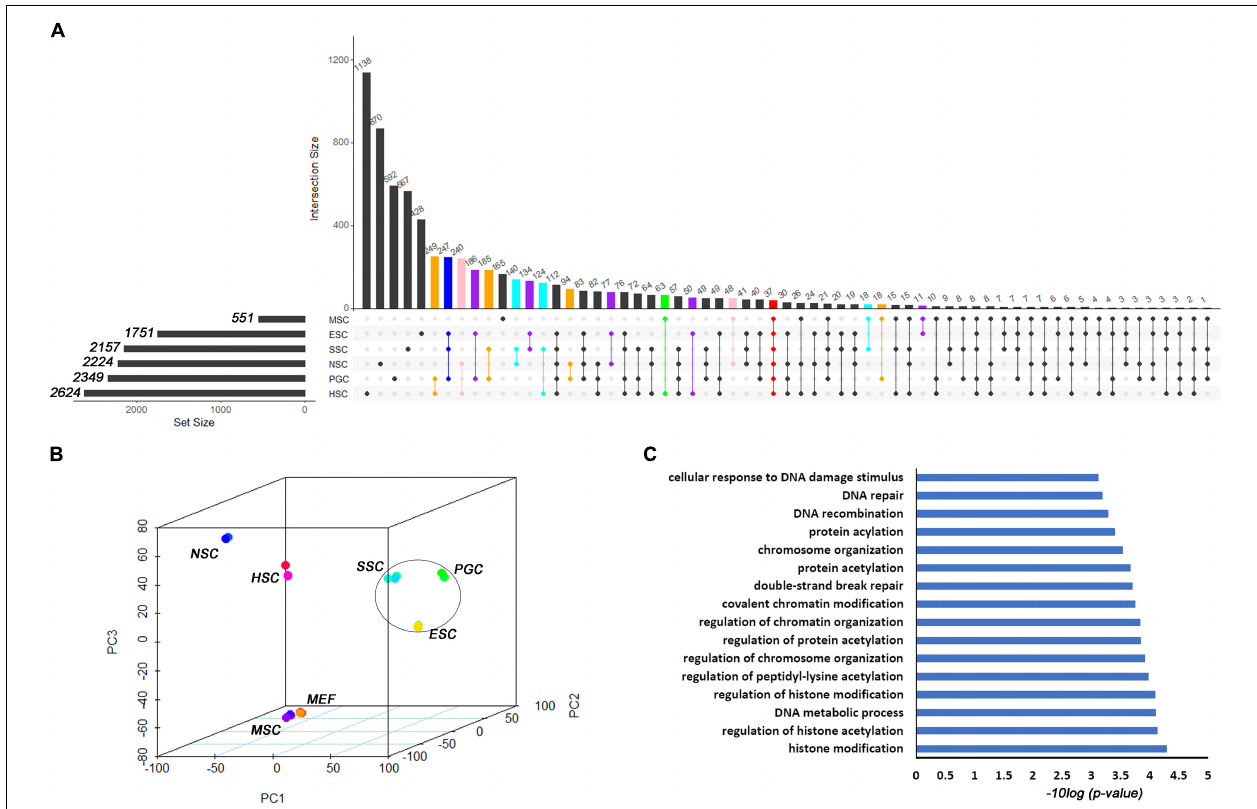
FIGURE 1 | Transcription profiles for ESCs, PGCs, SSCs, NSCs, MSCs, and HSCs. (A) The intersection of highly expressed genes from the six types of stem cells. Dots represents the intersections of the six types of stem cells in the Venn analysis. The bar represents the size of the individual intersections. Dots with lines show highly expressed genes shared by the lined stem cells types. Different intersections of those six types of stem cells are highlighted with different colors. The 37 commonly highly expressed genes among the six types of stem cells are highlighted with red bar. (B) PCA revealed differences among the six types of stem cells. (C) GO analysis of the biological function of the core 37 core commonly highly expressed genes. The benjamini-adjusted p value of < 0.05 was selected as threshold for enrichment of GO_BP_FAT terms.